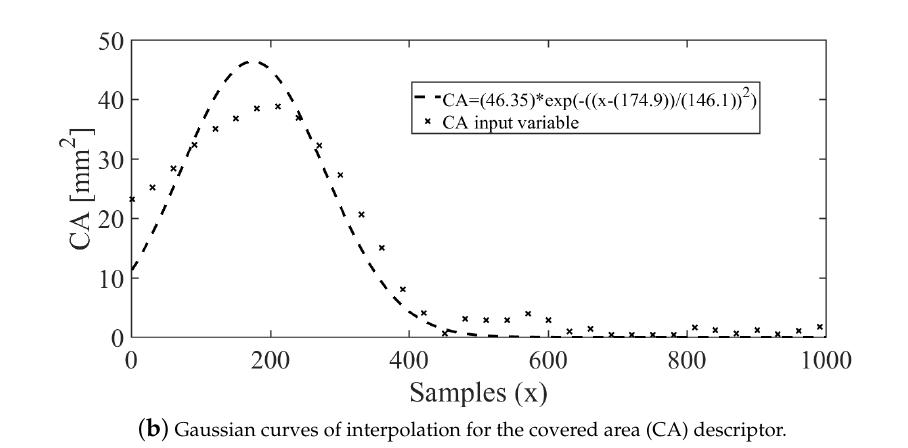
( b ) Gaussian curves of interpolation for the covered area (CA) descriptor.